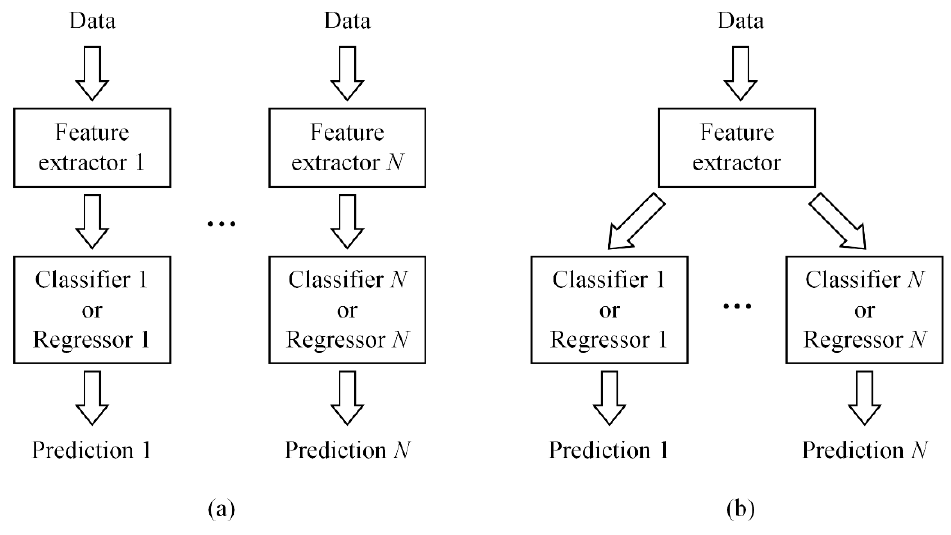
Figure 1. Different forms of multi-output prediction models. ( a ) Model consisting of a series of sub-models. ( b ) Model consisting of a public feature extractor and multiple predictors.